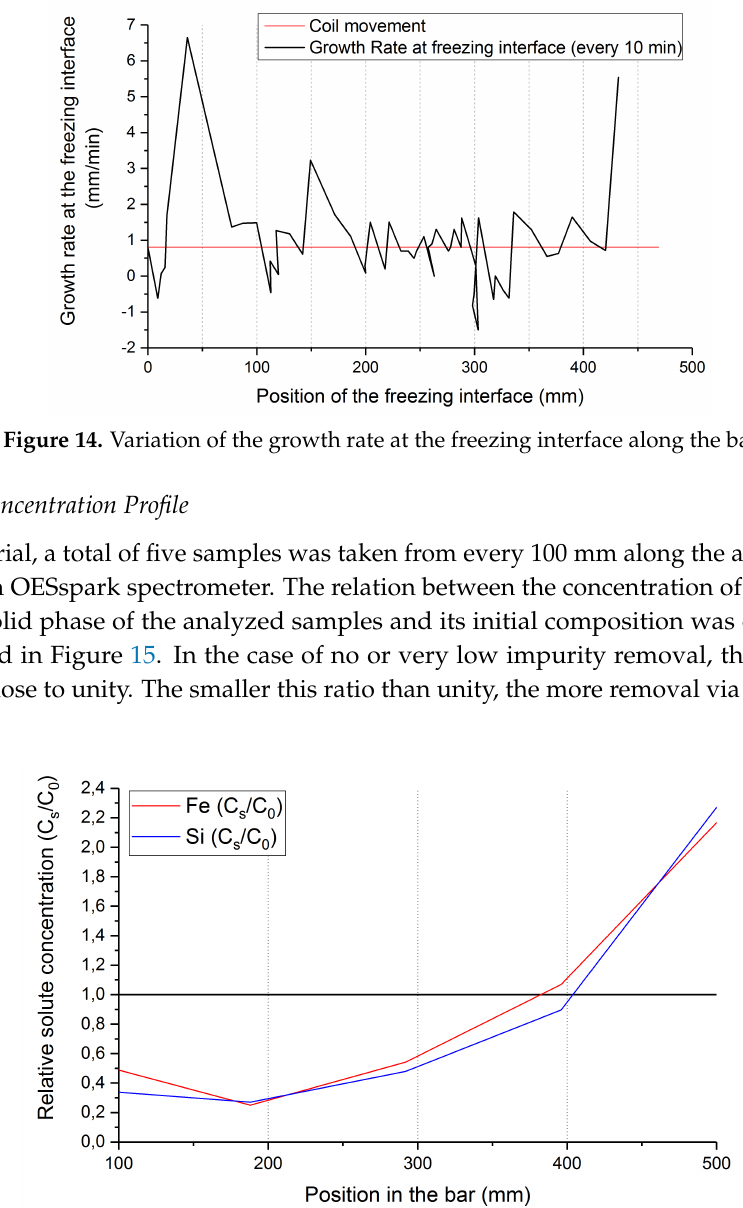
Figure 15. Relative concentration profile of Fe and Si along an aluminum bar subjected to one pass zone refining at 0.8